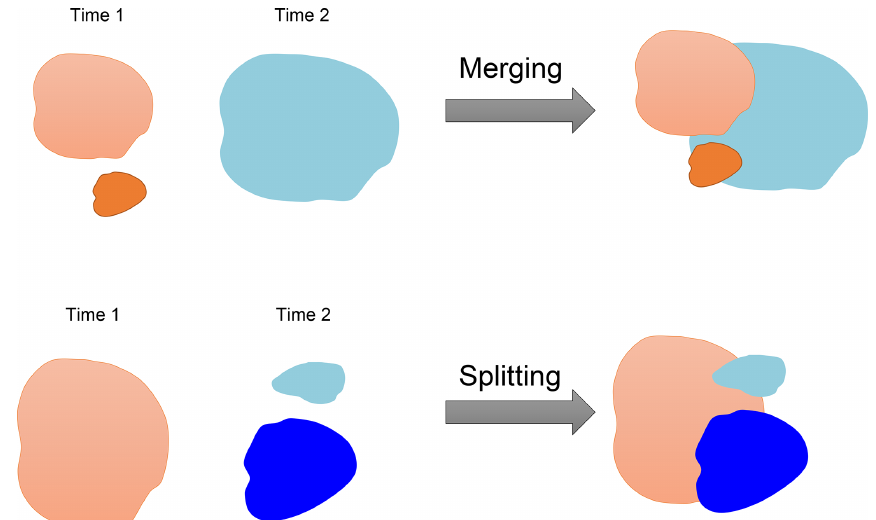
Figure A1. Schematic of CCS merging and splitting.